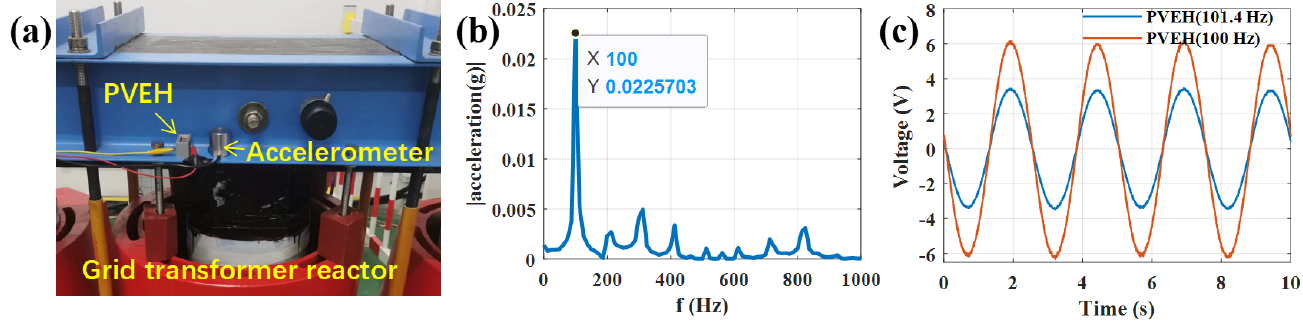
Figure 7. PVEH field application in grid transformer reactor: ( a ) Photo of PVEH field application; ( b ) Acceleration spectrum of grid transformer reactor; ( c ) Voltage time response curve at open circuit (load resistance of 10 MΩ).